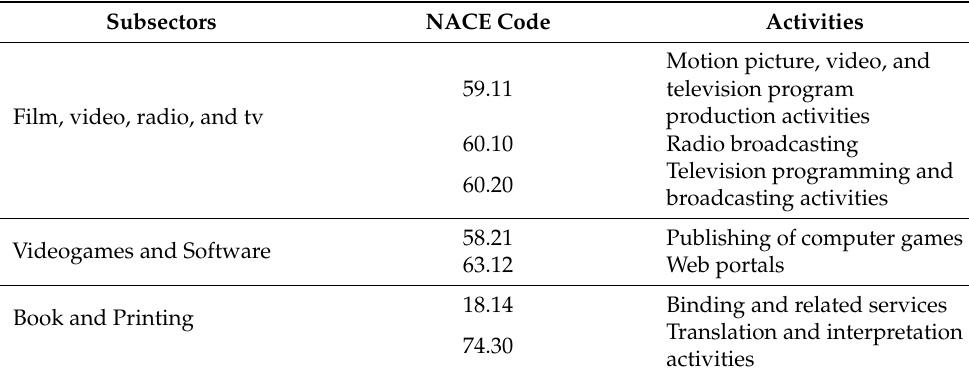
Table 2. Cross-border specialization in the Cultural Industries